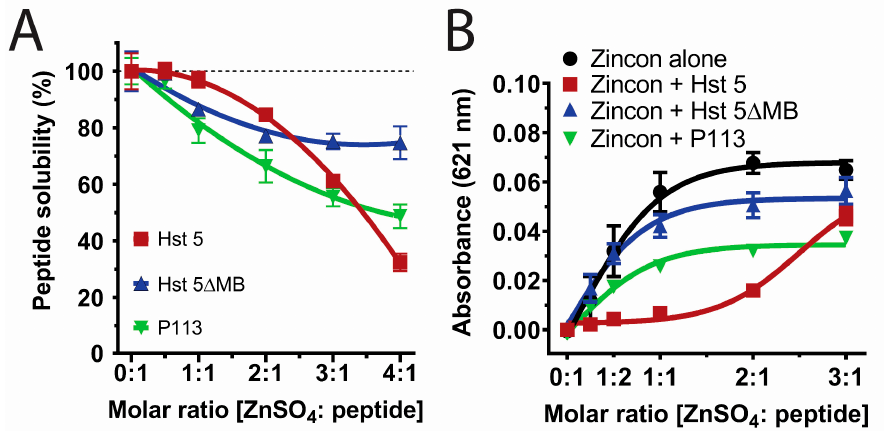
Figure 2. The three Hsts are all soluble at a physiological ratio of Zn 2 + to peptide but di ff er in relative Zn 2 + a ffi nity. ( A ) Percent solubility of 15 µ M Hst 5 (red), Hst 5 ∆ MB (blue), and P113 (green) in 10 mM sodium phosphate bu ff er pH 7.4 with increasing ratio of Zn 2 + incubated at room temperature for 30 min. Peptide solubility was measured via NanoDrop A205 after removal of insoluble aggregates by centrifugation. ( B ) Binding competition assay with Zincon and peptides at 20 µ M in 10 mM sodium phosphate bu ff er pH 7.4 to establish relative a ffi nity of Hst 5 (red), Hst 5 ∆ MB (blue), and P113 (green) for Zn 2 + at increasing molar ratios. Absorbance of Zincon at 621 nm was measured as an inverse indicator of relative peptide a ffi nity, as Zincon has a blue color when bound to zinc. Experiments were performed in triplicate and averaged.